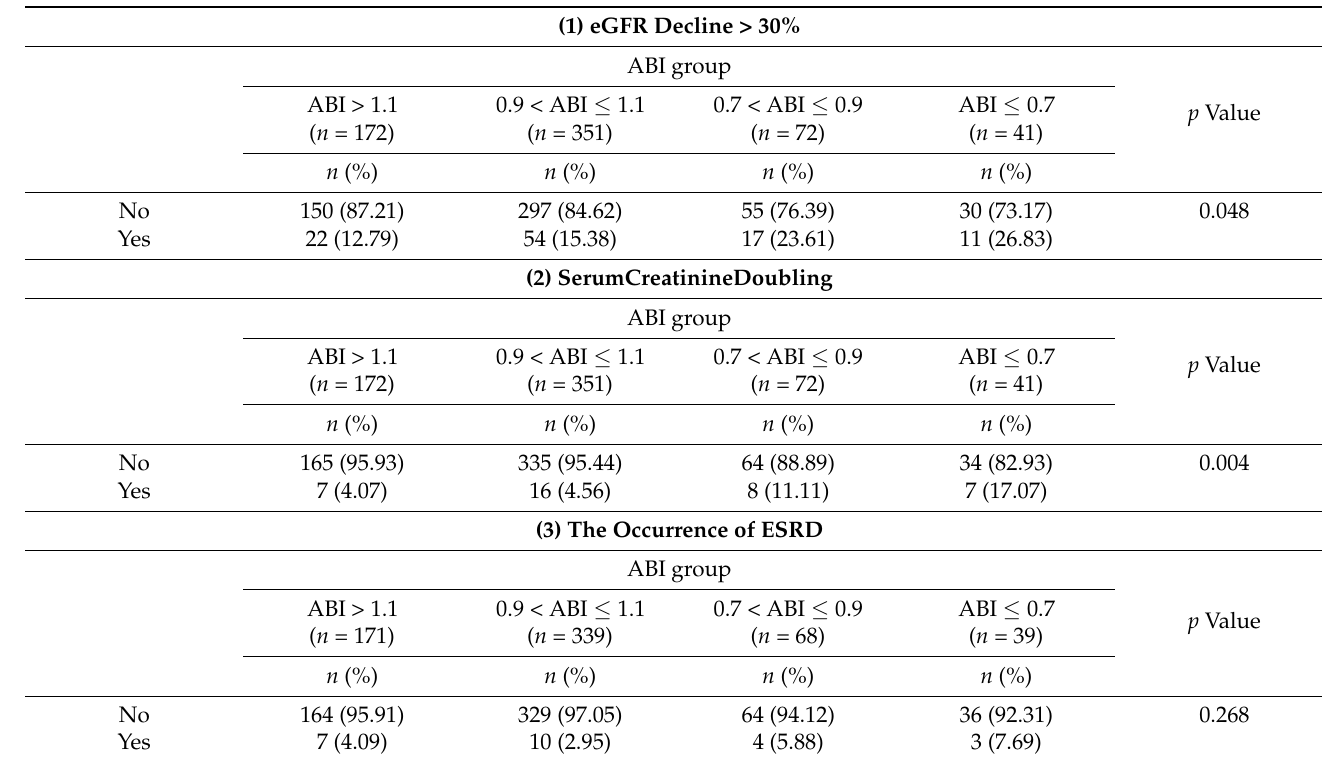
Table 4. Predictors of different renal outcomes during follow-up by different ABI